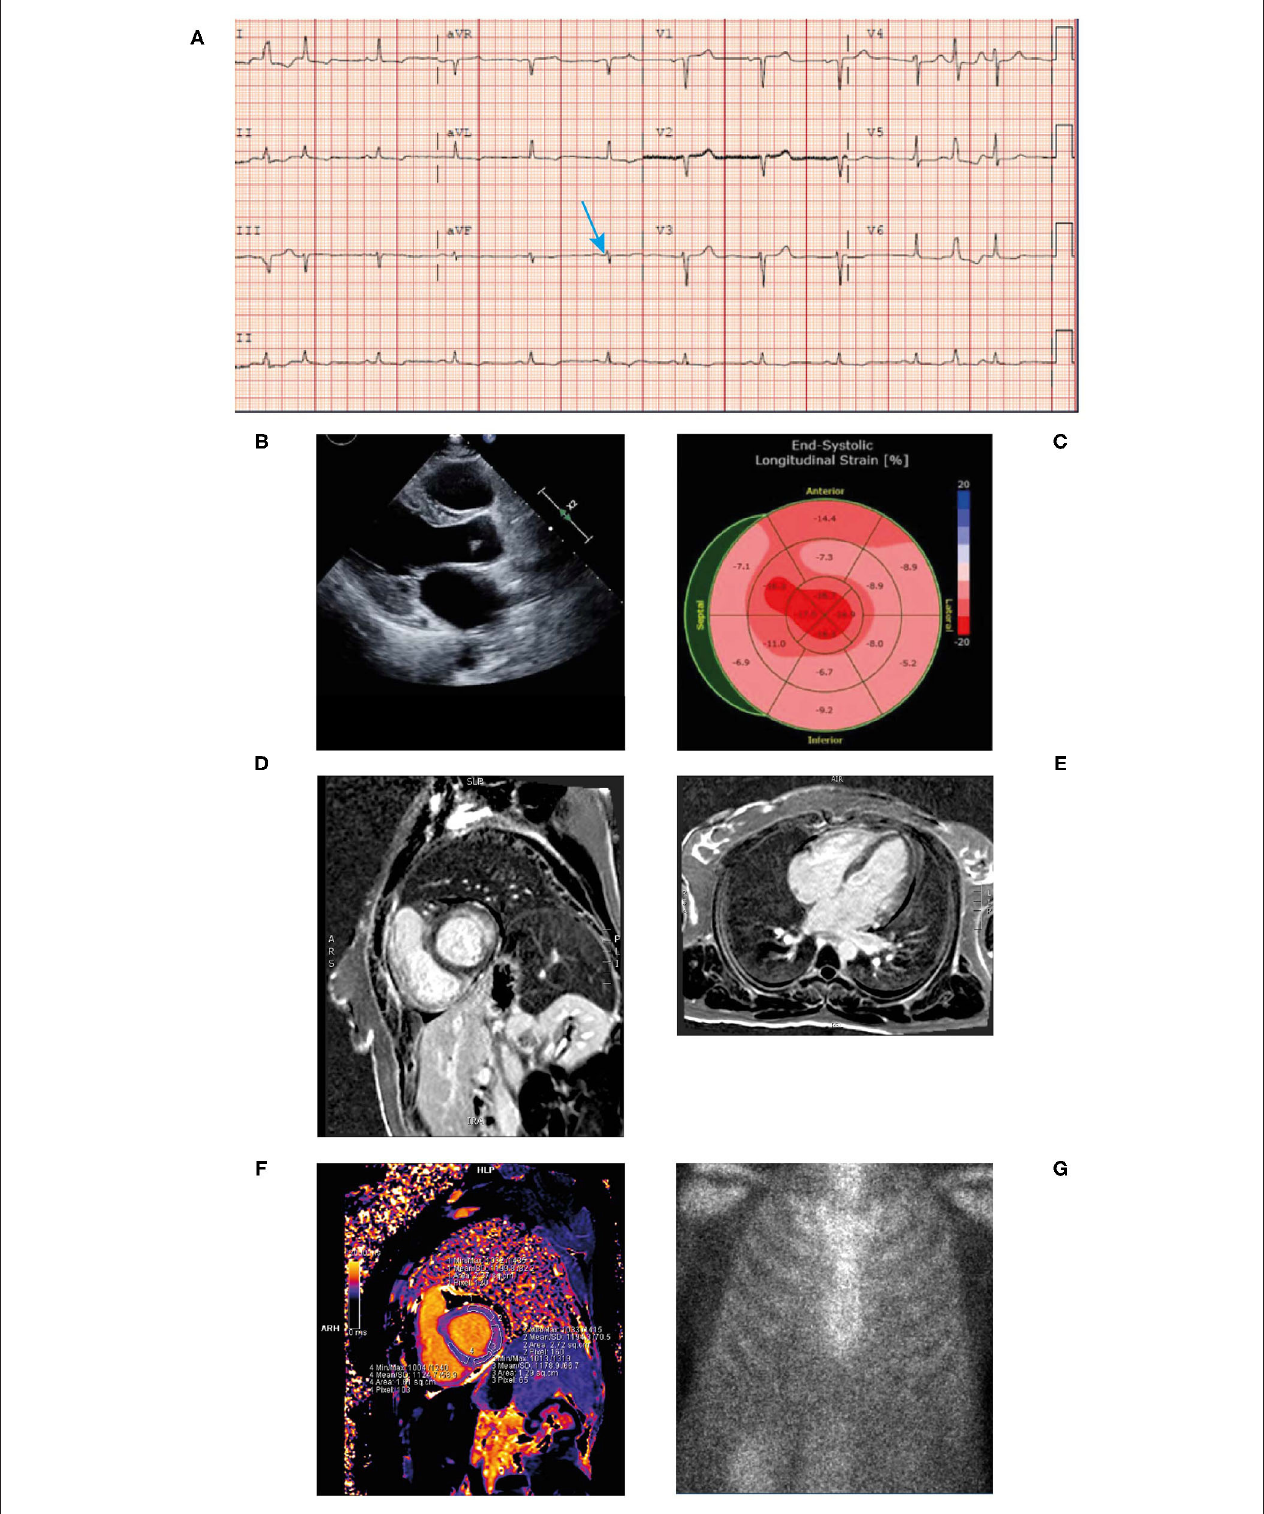
FIGURE 6 | ECG (A) showing low voltage particularly in the limb leads (blue arrow), atrial premature contraction, sinus rhythm, and poor R-wave progression across the anterior precordial leads. Low voltage discordant with marked LVH. Echocardiogram (B) demonstrating concentric LVH, EF of 50% and left atrial enlargement. End-systolic longitudinal strain (C) showing markedly reduced global longitudinal strain pattern − 11.8 with apical sparing. Cardiac MRI ( + gadolinium) (D,E) revealing